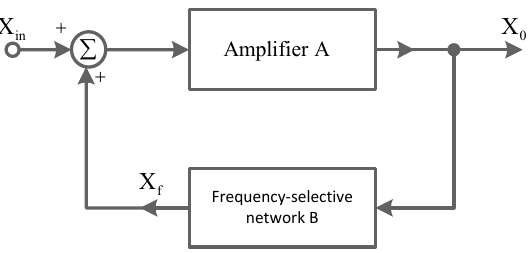
Figure 3. A positive-feedback system with a stable amplifier stage, A, and a frequency-selective network,